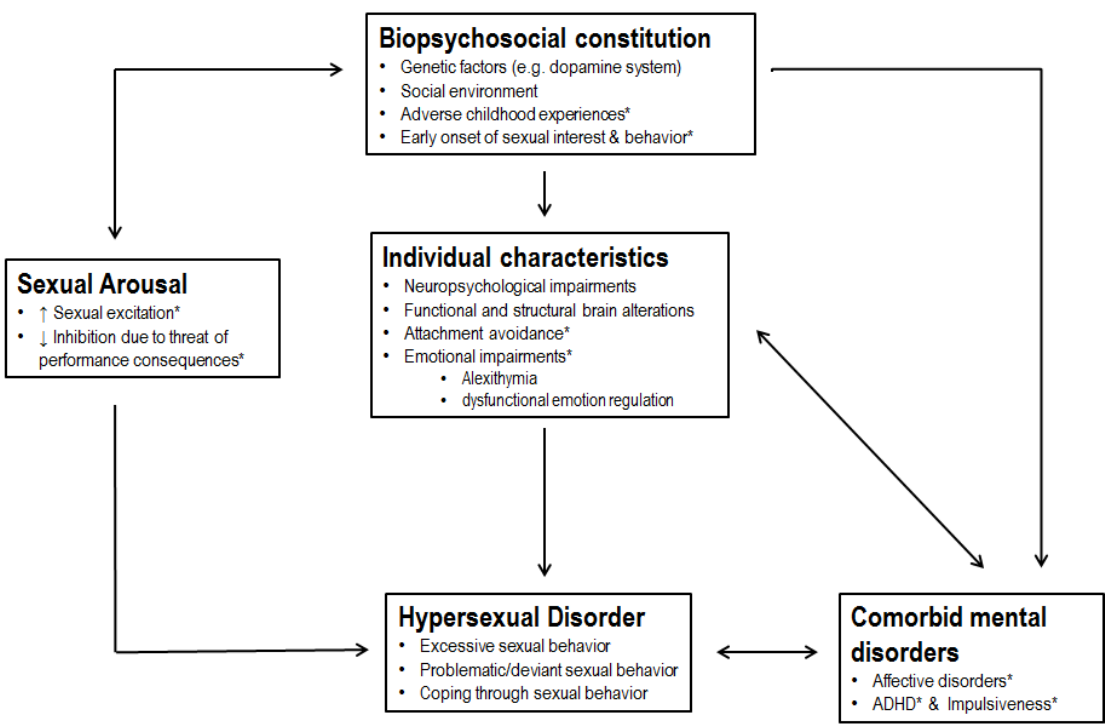
Figure 3. Working model of hypersexual disorder. We assume an underlying combination of genetic and environmental factors that may increase the likelihood of developing hypersexual disorder. A combination of biopsychosocial factors, e.g., genetic and epigenetic factors and adverse childhood events shape individual characteristics and increase the likelihood of developing comorbid psychiatric disorders. A high sexual arousal may be connected to genetic factors and may be both influenced by and influence early onset of sexual experiences. Dysfunctional characteristics of the individual, comorbid disorders, and high sexual arousal may lead to the development of hypersexual disorder. The factors marked with an asterisk were derived a posteriori from our results.